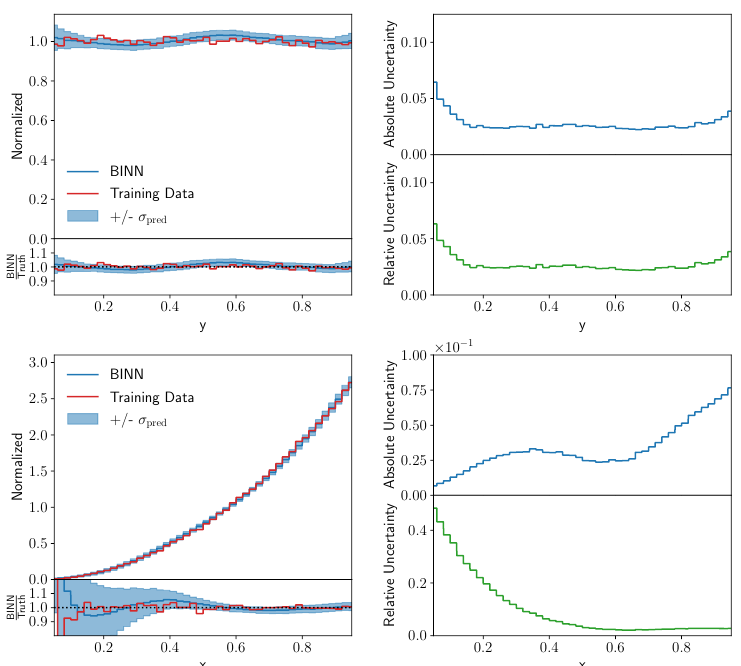
Figure 8: Marginalized densities and predictive uncertainties for the kicker ramp. Instead of the true distribution we now show the training data as a reference, to illustrate possible limitations. We use 10M phase space point to guarantee a stable